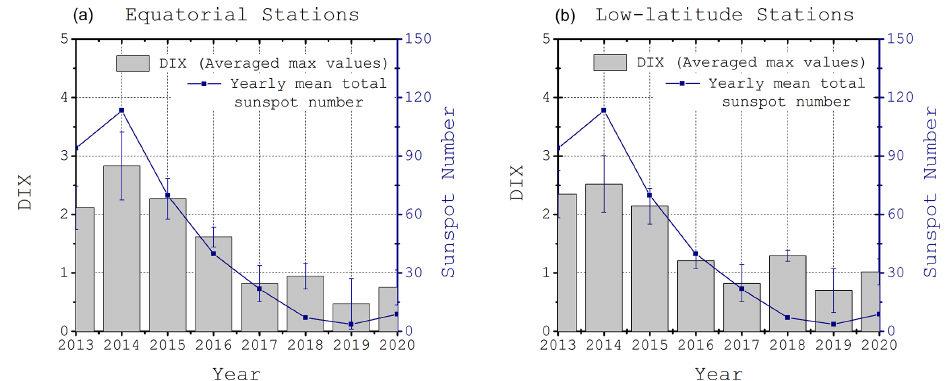
Figure 6. Averaged max DIX time variation during selected EPBs events observed from 2013 to 2020 over the equatorial (a) and low- latitude (b) GNSS stations along with the yearly mean total sunspot number for the same